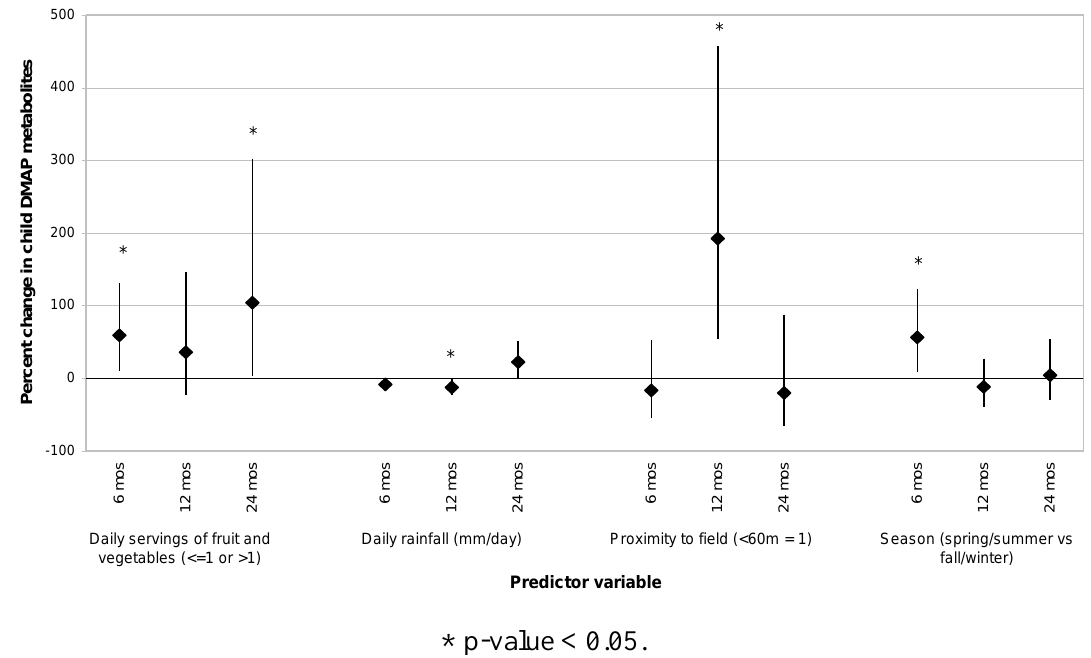
Figure S1. Percent change (and 95% CI) in DMAP metabolite per unit change or yes/no difference in predictor variable by child’s age.